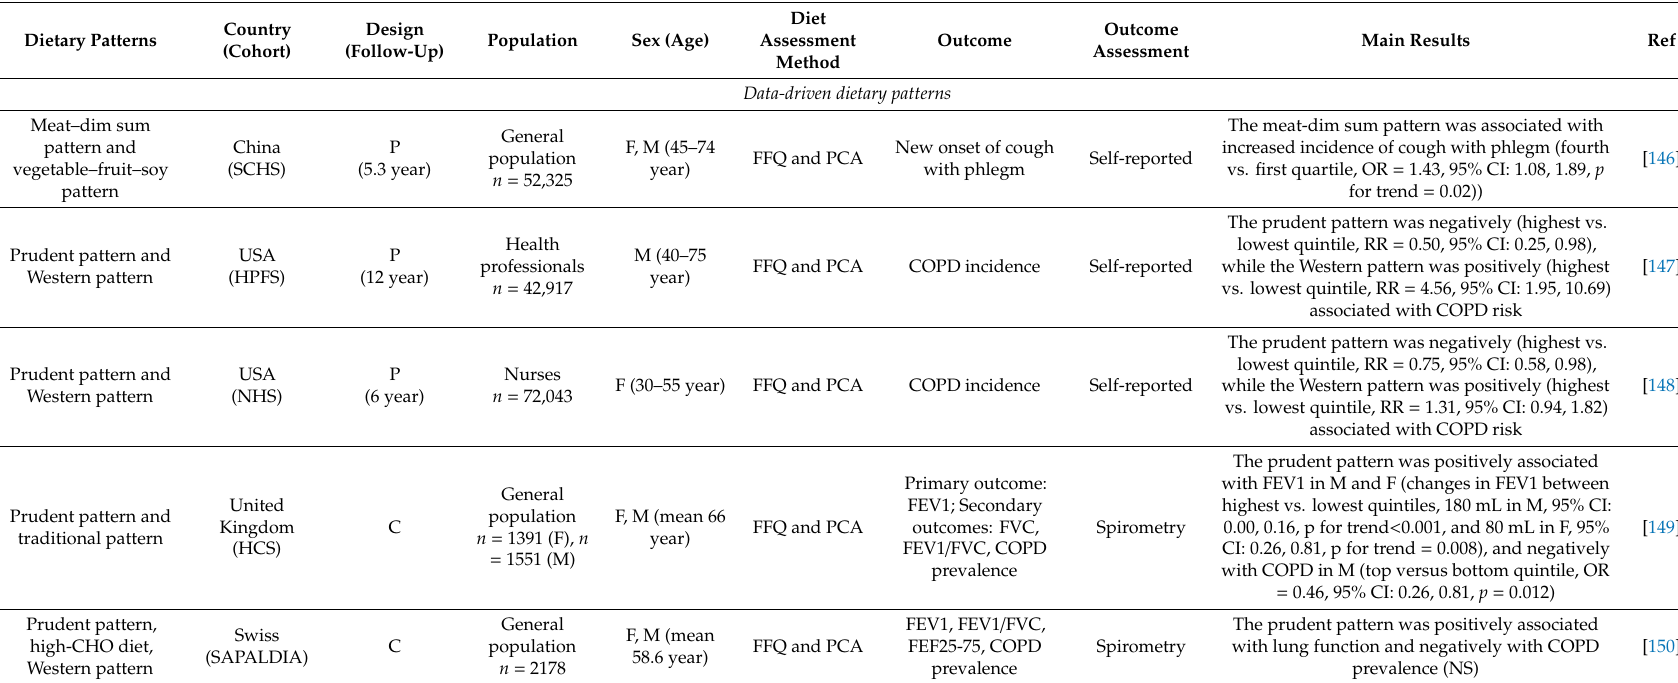
Table 1. Main findings from epidemiological studies linking dietary patterns to adult lung function and chronic obstructive pulmonary disease (COPD) (incidence, prevalence, and